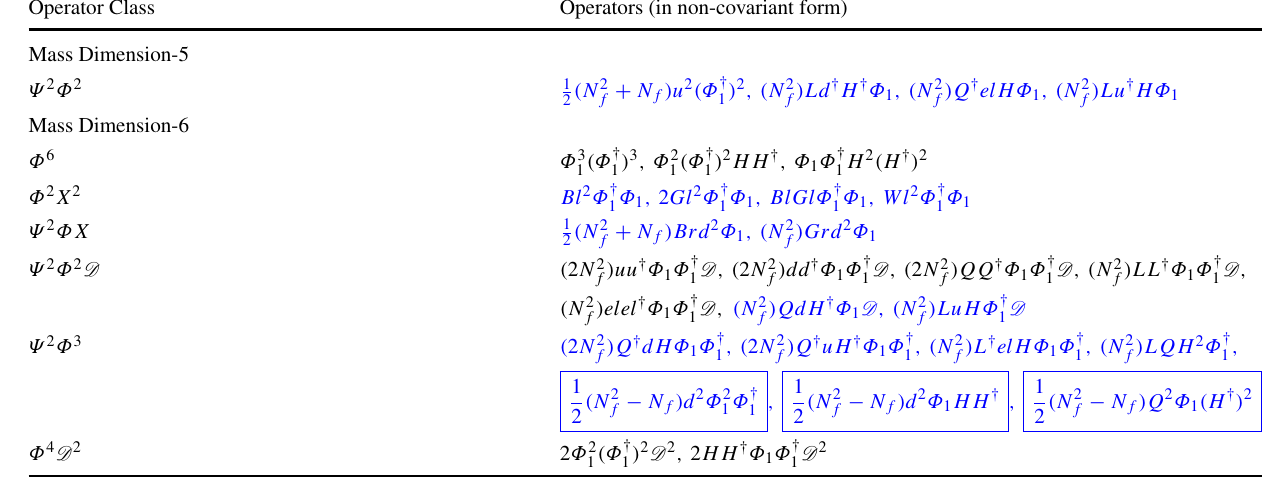
Table 41 Lepto-Quark Model 3( Φ 1 ): operators of mass dimensions-5 and -6 excluding pure SM operators Operator Class